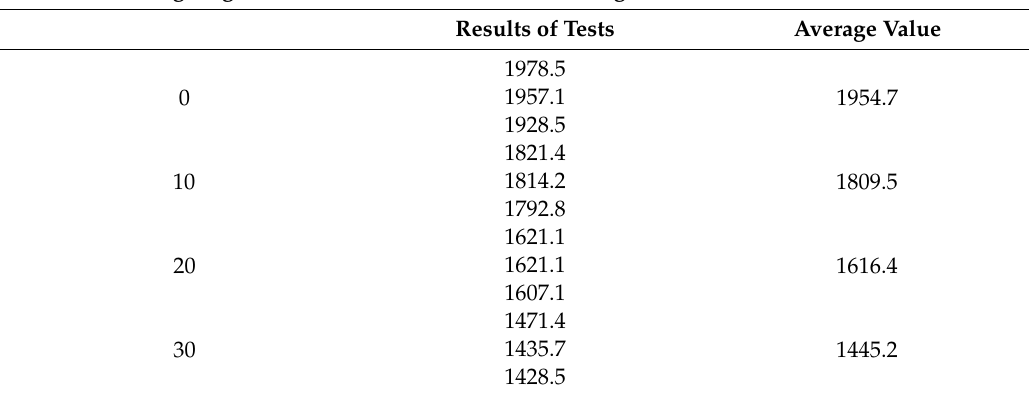
Figure 18. Seven-wire strands and reaction frame in the tensile test. Table 2. Ultimate tensile strengths of the seven-wire strands at different lateral bending angles in the tests. Lateral Bending Angle θ (mrad)